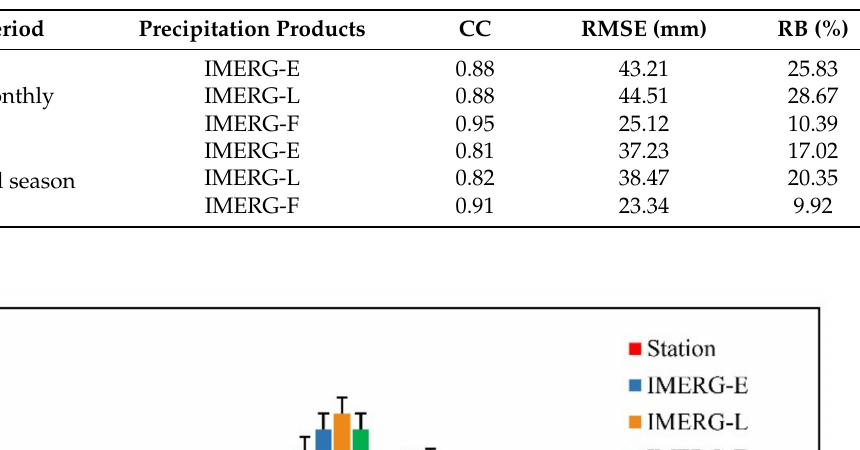
Table 5. Average continuous verification statistics for IMERG precipitation estimates. Monthly indicates statistics for monthly estimates for each month between January 2001 and December 2016.